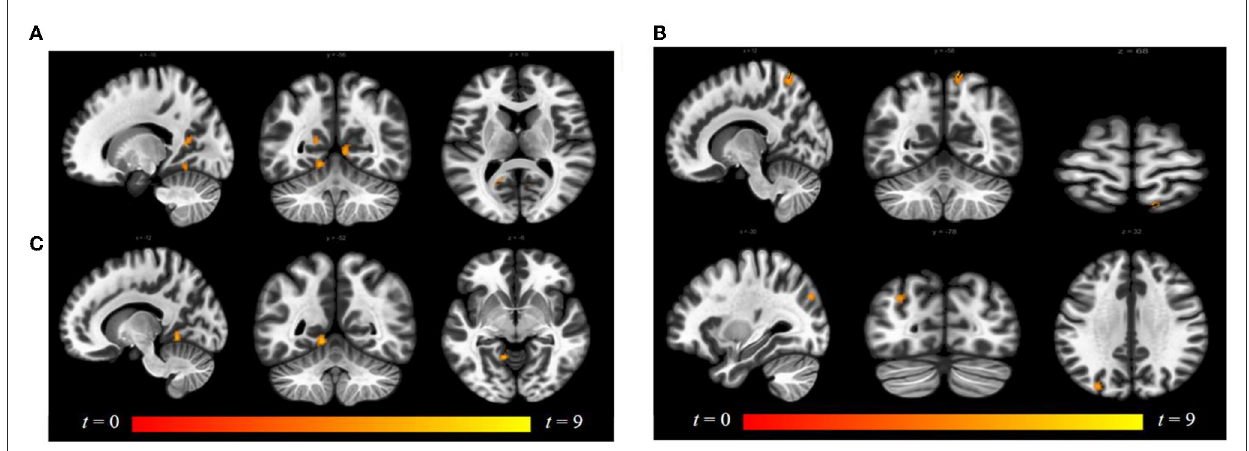
FIGURE5 Within-group differences between luteal phase and follicular phase. The hot color scale indicates (A) higher left insula–precuneus, right and left lingual gyrus resting-state functional connectivity (RSFC) in the luteal than follicular phase, as well as increased (B) right insula–precuneus, lateral occipital cortex, and (C) ACG–left lingual gyrus. Coordinates are given in MNI space and statistics in t -values. ACG, anterior cingulate and paracingulate gyri.